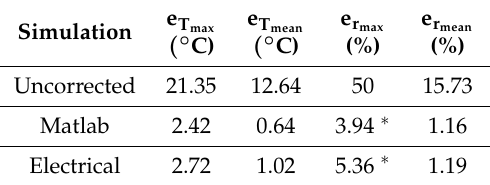
Figure 18. Comparison between the non-linear characteristic NL1 and the corrected output electrical characteristic: ( a ) relative error e r and ( b ) temperature estimation error e T . Table 6. Comparison between the Matlab and electrical simulations performed in Cadence by considering the 1-5-1 neural architecture and the non-linear thermistor response (NL1).